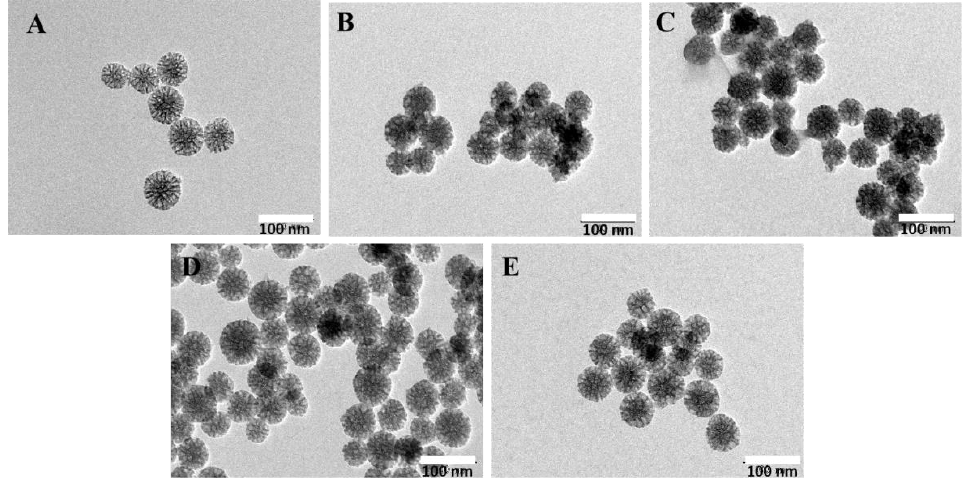
Figure 1. TEM photographs of MSNs ( A ), MSNs-COS ( B ) and MSNs-COS-MAC ( C ). ( D ) MSNs-COS- MAC dispersed in a pH 1.0 hydrochloric acid solution for one hour. ( E ) MSNs-COS-MAC dispersed in distilled water for one